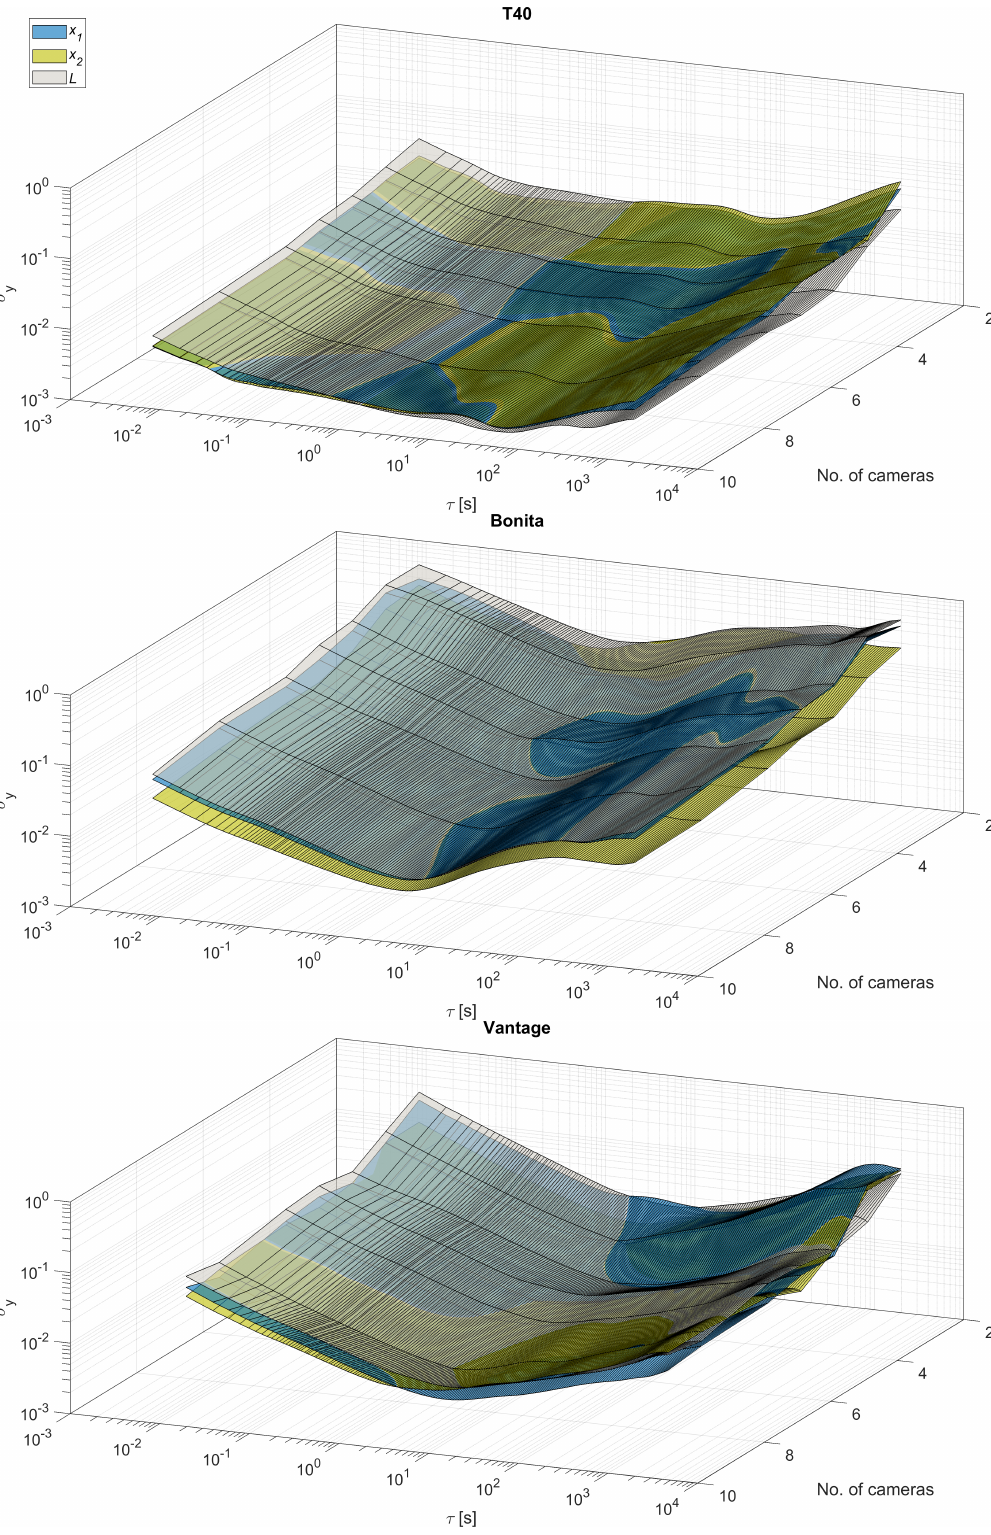
Figure 12. ADEV versus time plots for varying number of cameras (2...max) for three camera types, listed top–down: T40, Bonita,